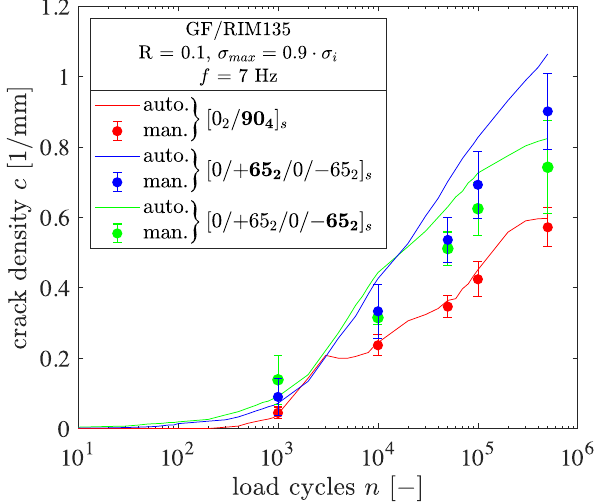
Figure 7. Comparison of manually and automatically detected cracks in [ 0 2 /90 4 ] s - and [ 0/ + 65 − 65 ] s -laminates, 2 /0/ 2